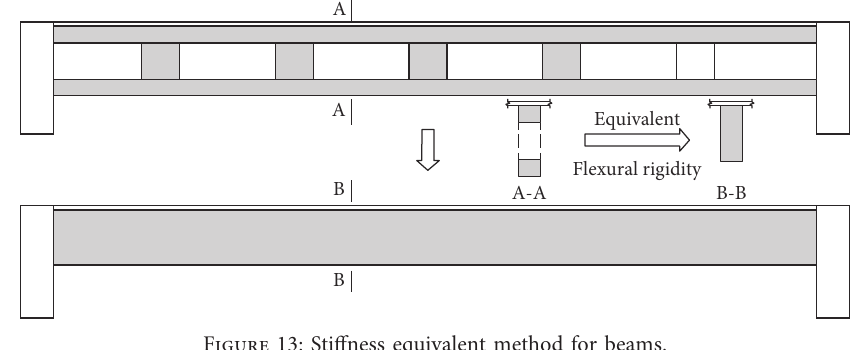
Figure 13: Stiffness equivalent method for beams.